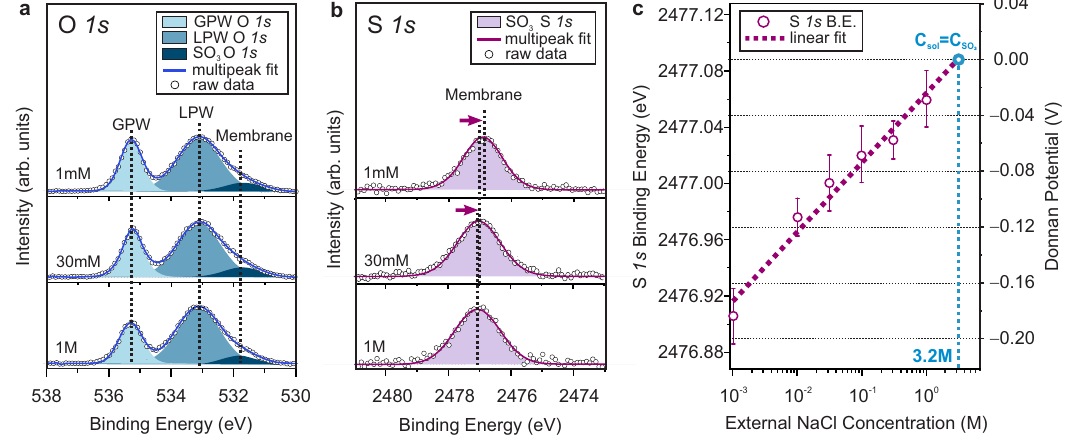
Fig. 2 | Experimental measurements of the Donnan potential. Representative a O 1s and b S 1s core level spectra collected from CR-61 membranes equilibrated withdifferentconcentrationsofNaClsolutions(GPW:gasphasewater,LPW:liquid phase water). The binding energy is calibrated using bulk liquid phase water. The effects of the EDL on the binding energy position of the LPW peak are considered, and corrections are made during the calibration process. (Details of the energy calibration process are set forth in Supplementary Note 4) Circles represent raw experimental data, and lines indicate the sum of fi ts. Representative spectra not provided here for three other concentrations of NaCl solutions are presented in Supplementary Fig.6 for visualinspection. c AveragedS 1s binding energy and the